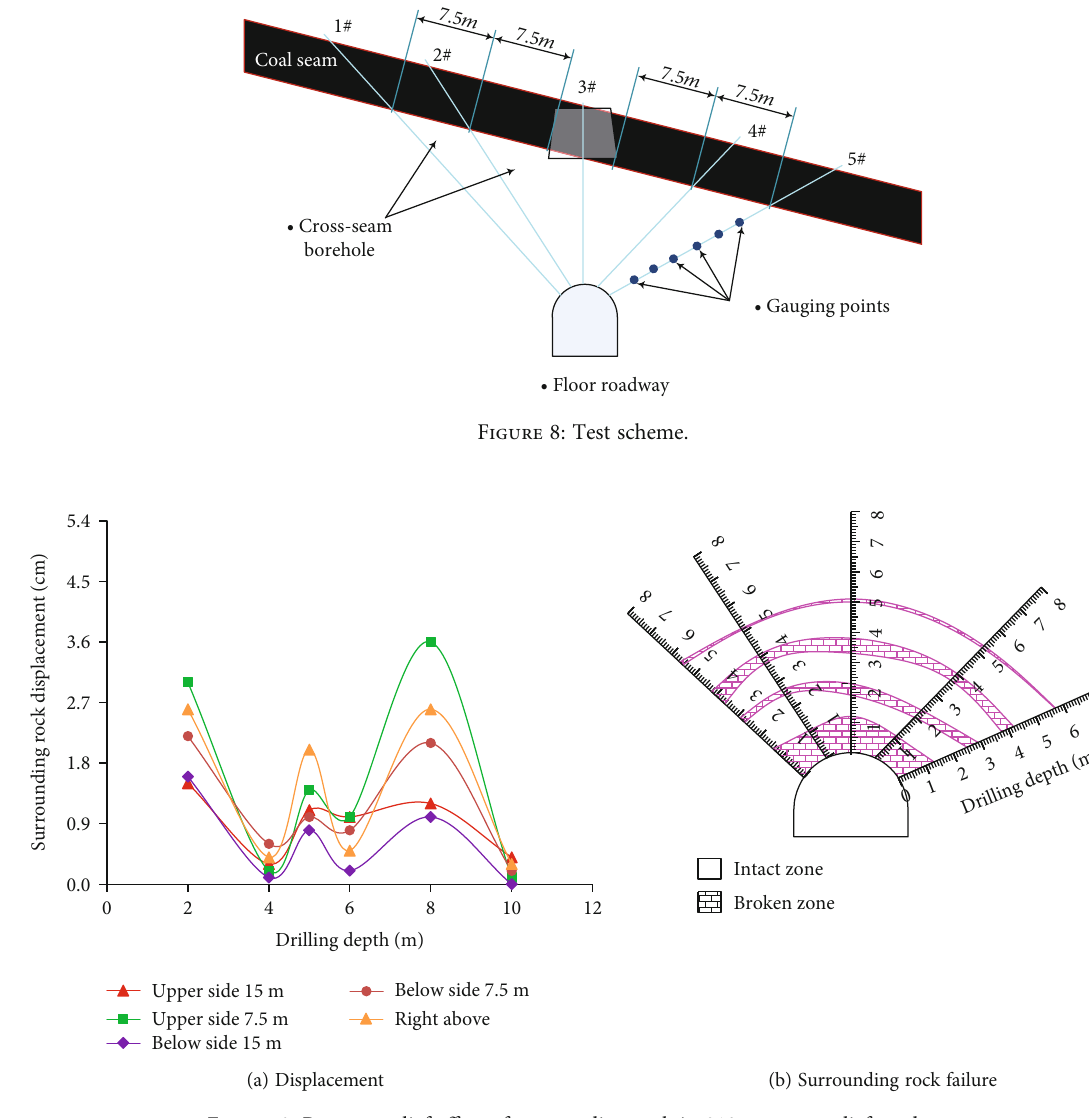
Figure 9: Pressure relief e ff ect of surrounding rock in 213 pressure relief